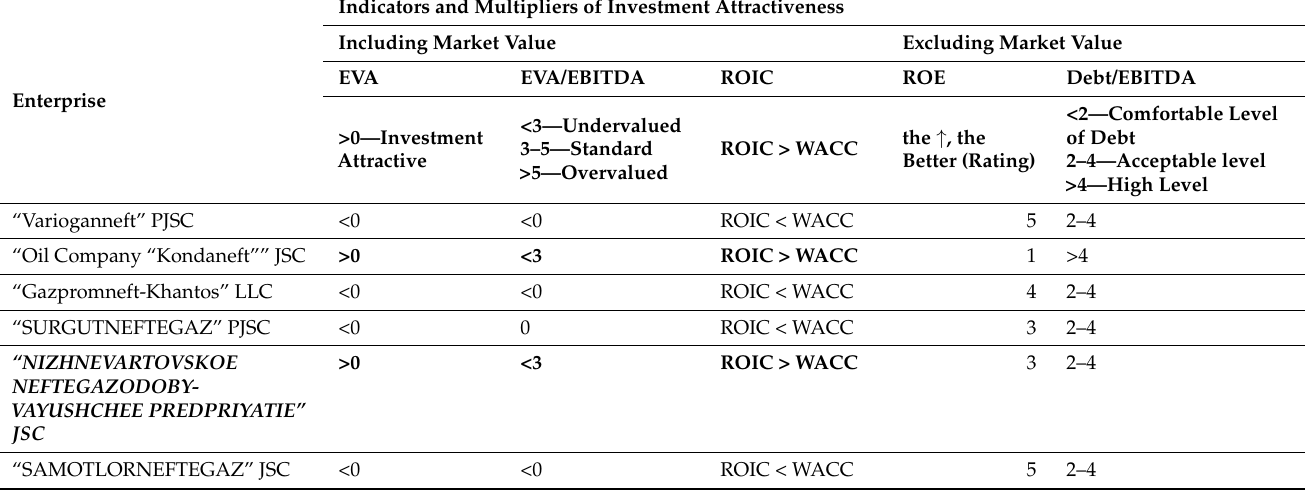
Table 3. Assessment of the investment attractiveness of extractive industry enterprises in the fuel and energy complex of the Ural Federal District (table fragment).